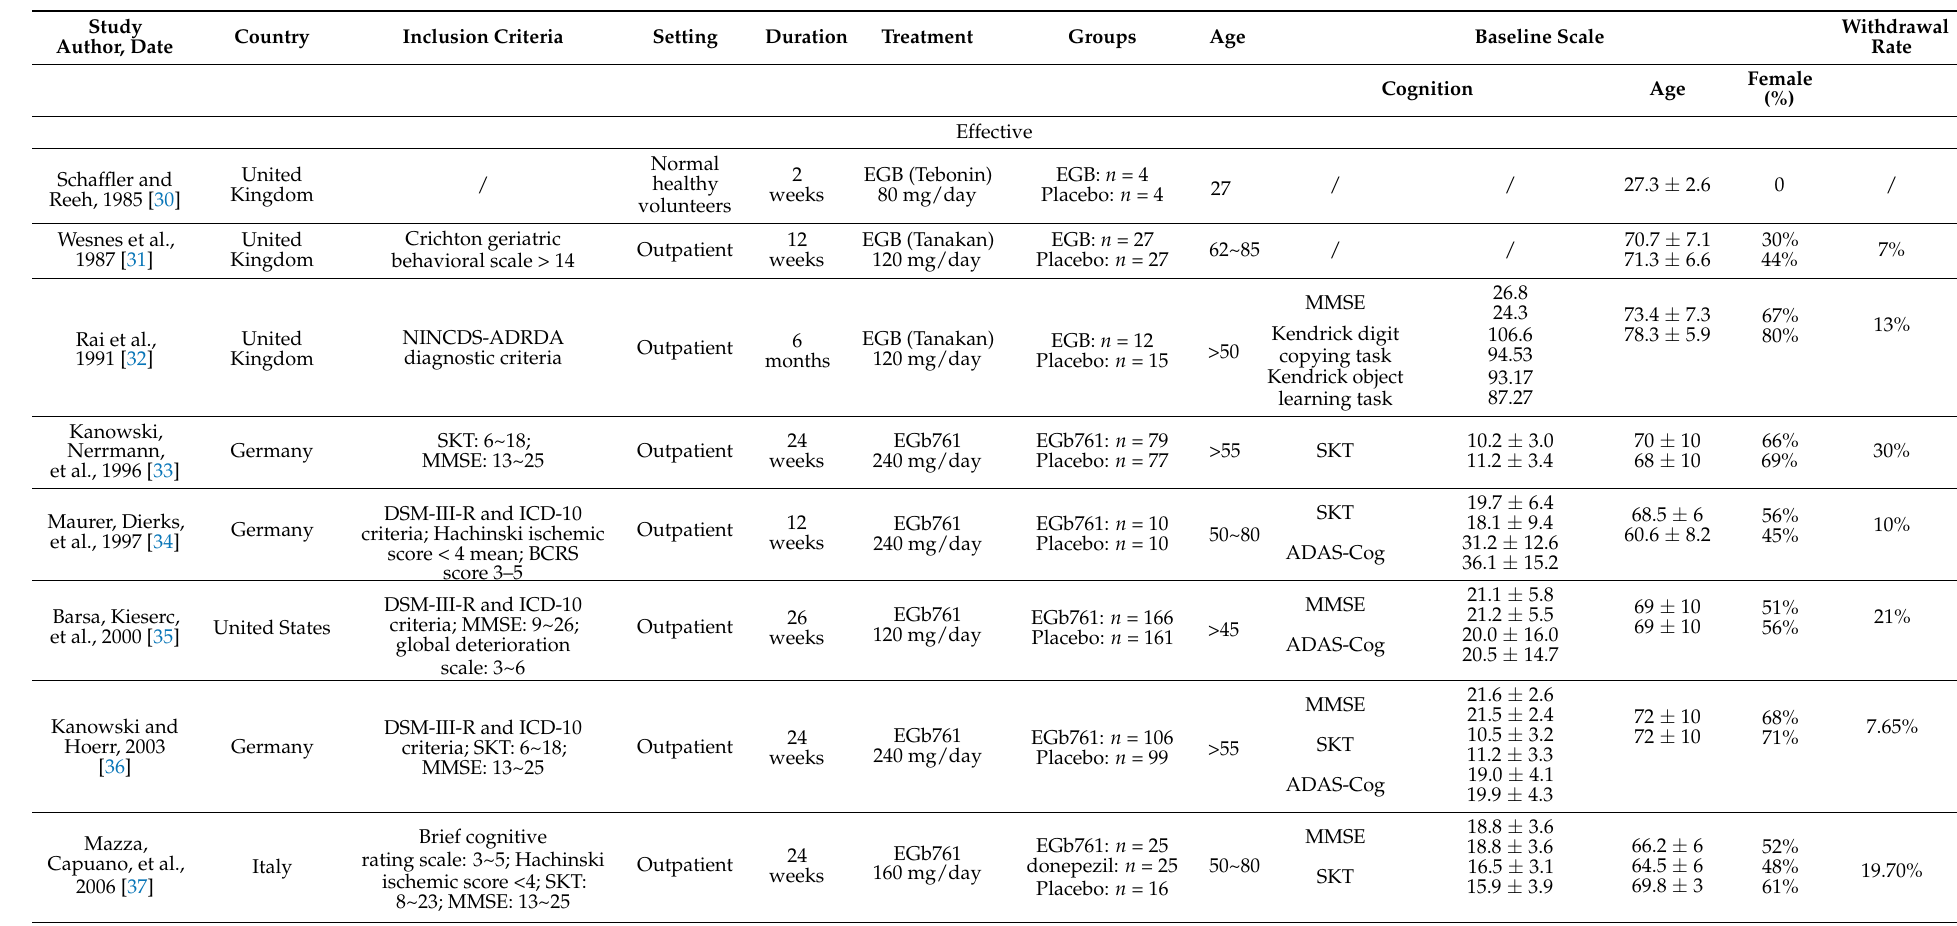
Table 4. Characteristics of included clinical studies related to